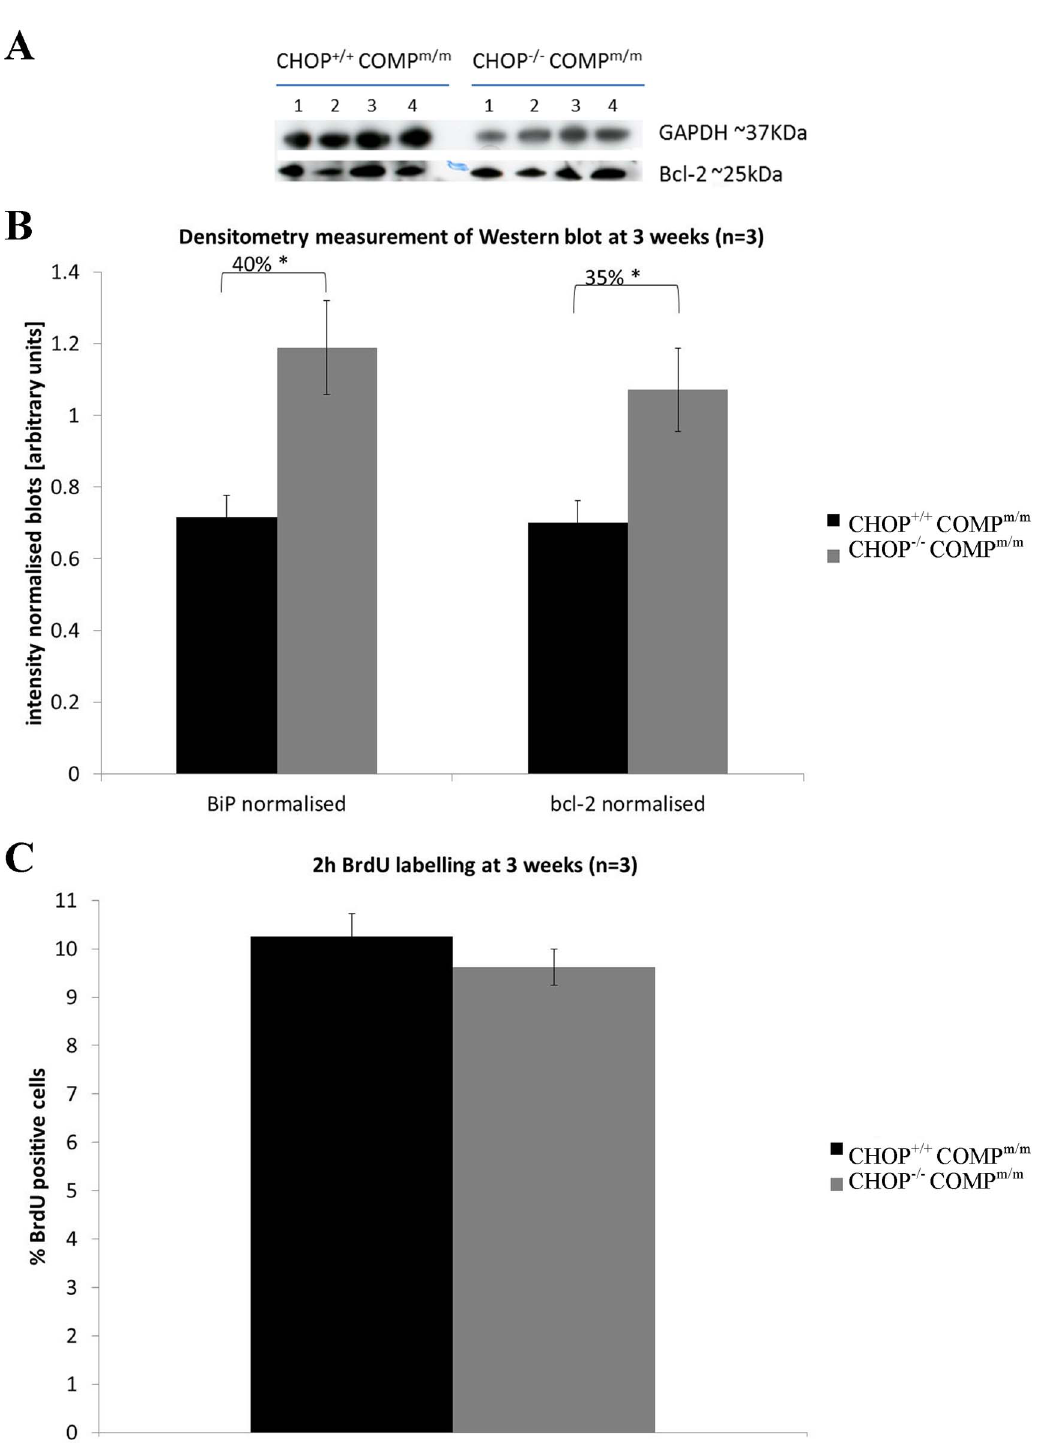
Figure 7. Western blot and BrdU analysis of mouse cartilage at 3 weeks of age. A ) A representative image of a bcl-2 Western blot on mouse xiphoid homogenates at 3 weeks. 4 mice per genotype (1–4); GAPDH was used as a loading control. B ) Densitometry of Western blots of cartilage homogenates from xiphoid cartilage showing an significant increase in bcl-2 and BiP protein after CHOP removal (n=3; t-test) B ) Quantification of the relative number of BrdU positive cells in T585M COMP mutant and either CHOP wild type [CHOP + / + COMP m/m ] or knock-out [CHOP 2 / 2 COMP m/m ] growth plate showing that CHOP deletion had no effect on chondrocyte proliferation (n=3; t-test). Key: CHOP + / + COMP m/m =CHOP wild type and T585M COMP mutation (homozygous); CHOP 2 / 2 COMP m/m =CHOP null and T585M COMP mutation (homozygous). Error bars show standard error of the mean (SEM); * P , 0.05.